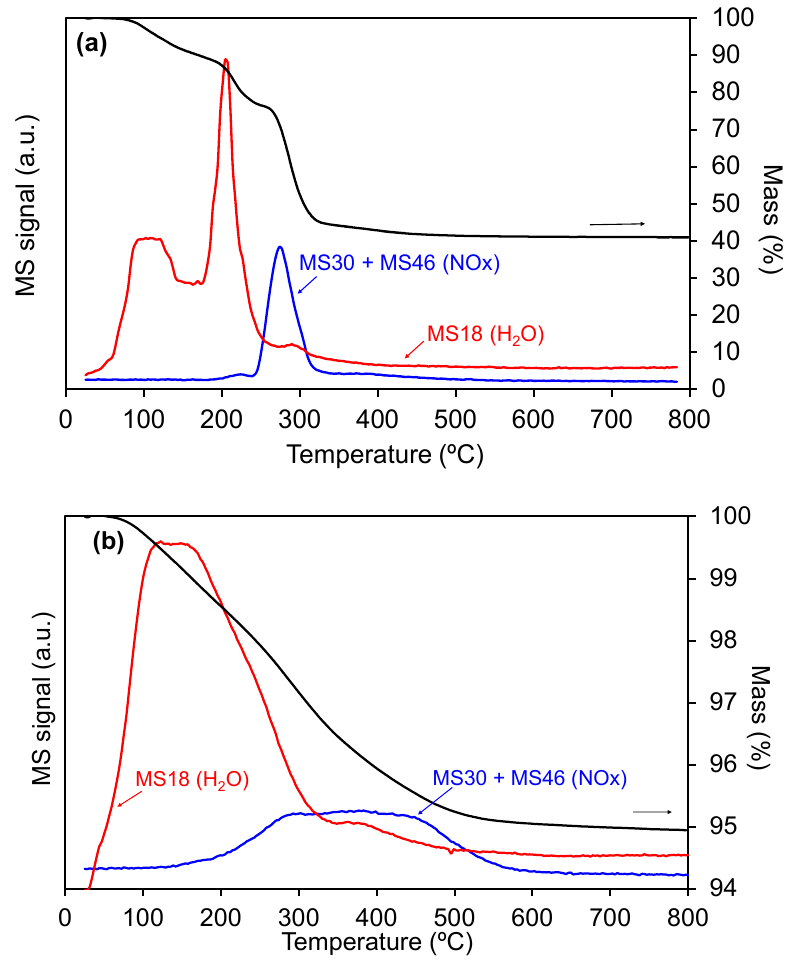
Figure 1. Metal precursors decomposition followed by TG-MS. ( a ) Ce(NO 3 ) 3 ·6H 2 O and ( b ) Rh(NO 3 ) 3